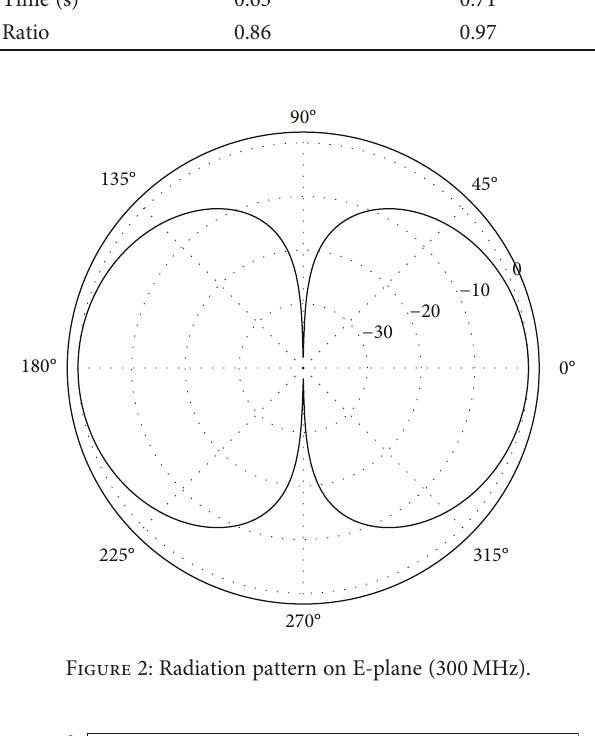
Figure 2: Radiation pattern on E-plane (300MHz).